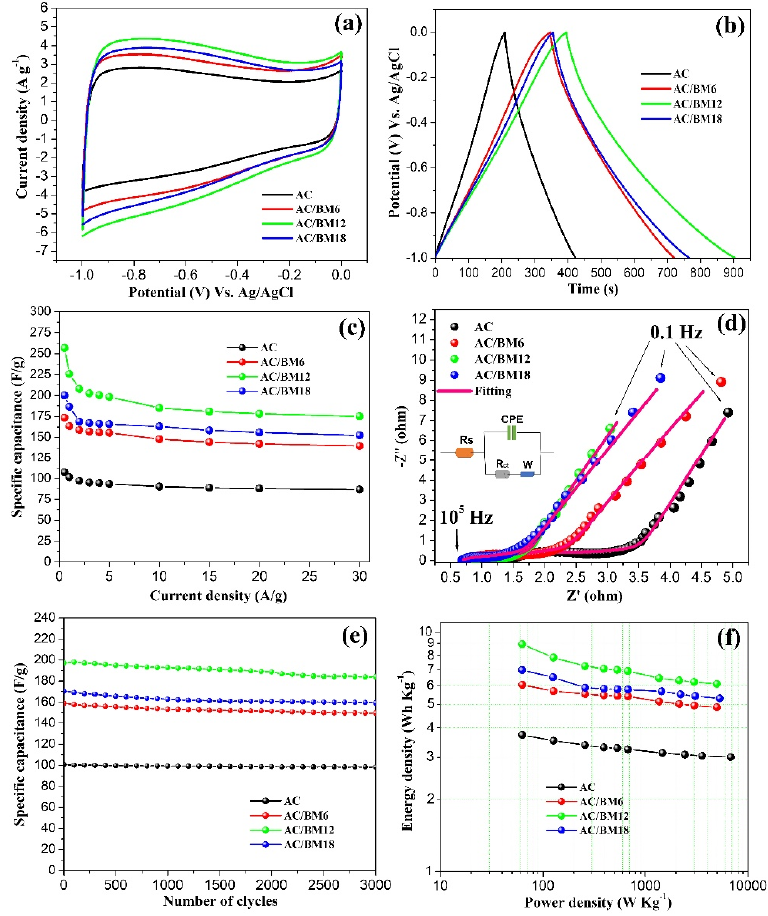
Figure 8. ( a ) CV curves at a scan rate of 20 mV s − 1 , ( b ) GCD curves at a current density of 0.5 A g − 1 , ( c ) specific capacitance (C sp ) at various current densities, ( d ) Nyquist plots, ( e ) the cycling retention at 5 A g − 1 and ( f ) Ragone plot of energy density and power density for AC, AC/BM6, AC/BM12 and AC/BM18 electrodes. Table 3. Comparison of the properties of various biomass ‐ derived carbon sources used in superca ‐ pacitors.